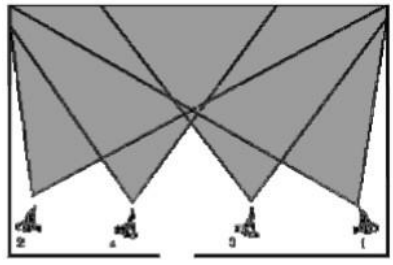
Figure 2. Final position of fire team for side entry room (US Army, 2002, [183]).